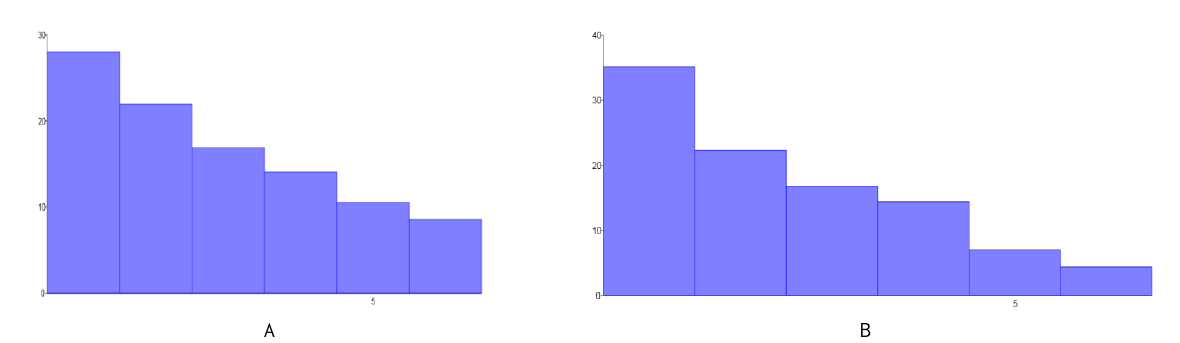
Figure 2. PC scores for left (A) and right (B) covariate matrices antisymmetry. OX – principal component; OY – % variance First principal component of left covariate matrix included less (27.9%) overall variance, right first component included (35.1%). This affirmed the difference in variances left and right data. The asymmetry covariance matrix was checked on variation in asymmetry component for levels: population, tree, and leaf. The analysis of a scatter plot of differences between left and right sides demonstrated that the analyzed samples (level of leaf) display the pair wise correlation of PLS score between left (№№2, 3, 4, 5) and right (№№7, 8, 9, 10) homologues landmarks was r = 0.38